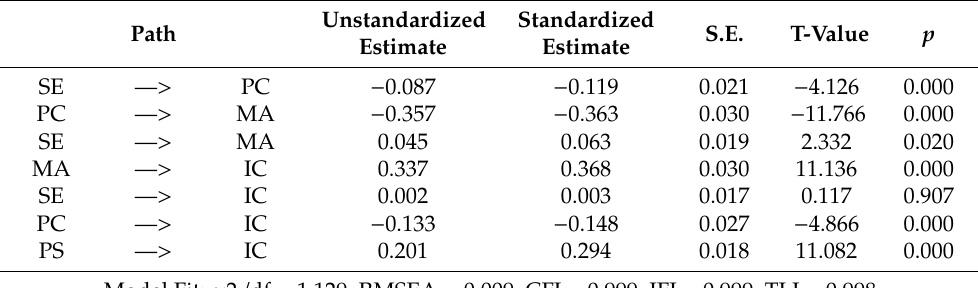
Table 5. Path analysis results (N = 1548).